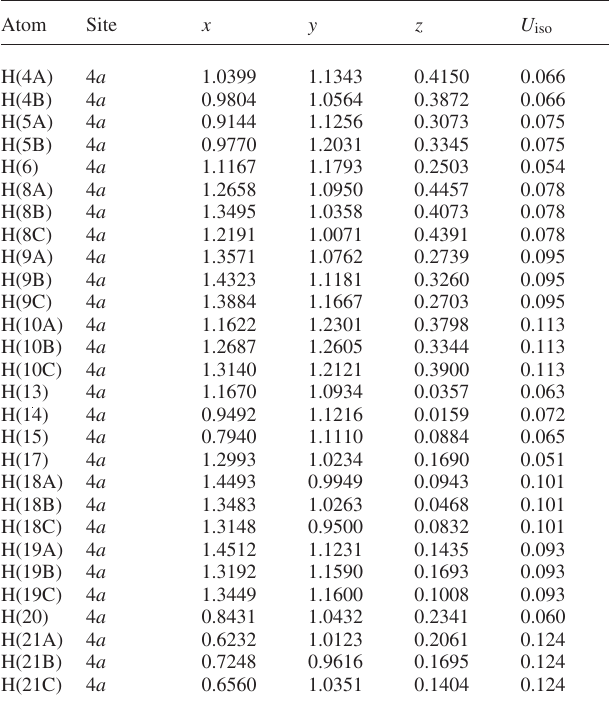
Table 2. Atomic coordinates and displacement parameters (in Å 2 )